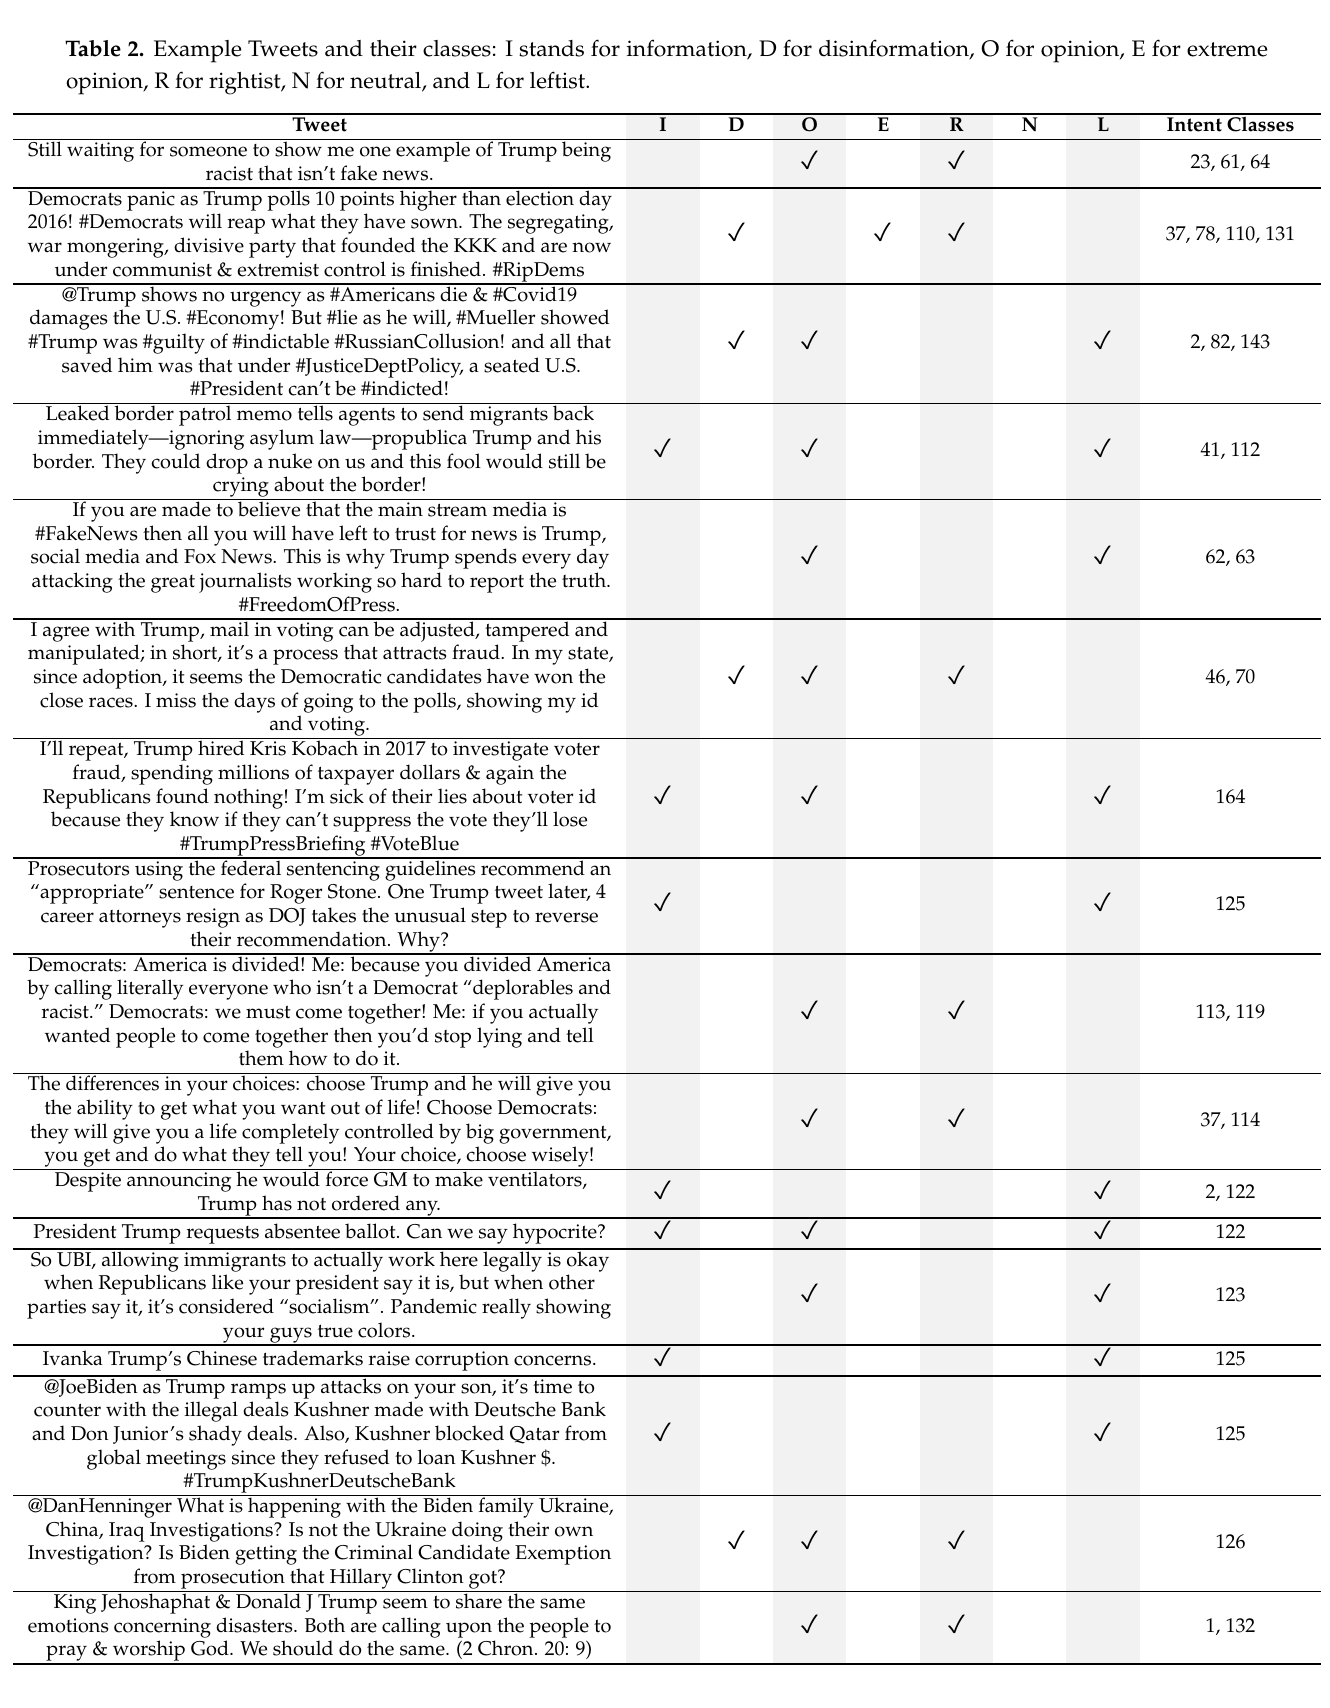
Table 2. Example Tweets and their classes: I stands for information, D for disinformation, O for opinion, E for extreme opinion, R for rightist, N for neutral, and L for leftist.